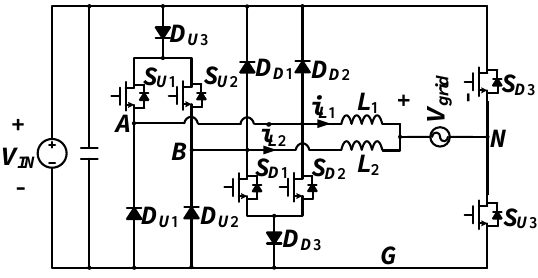
Figure 2. Circuit structure of the proposed inverter.